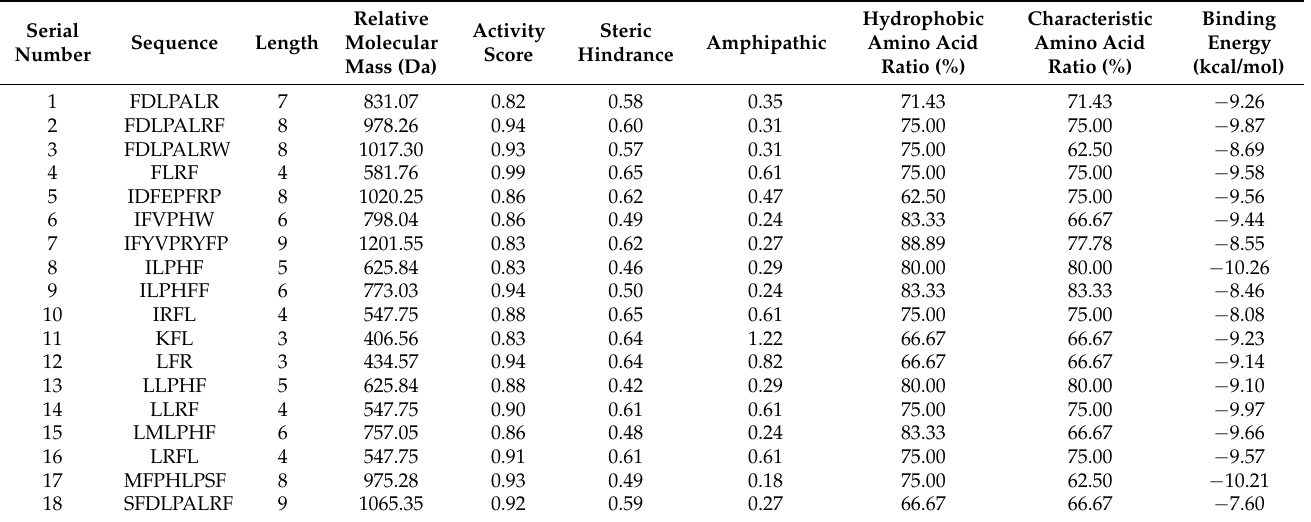
Table 1. Physiochemical characteristics, activity scores and binding energy with ADH from synthetic